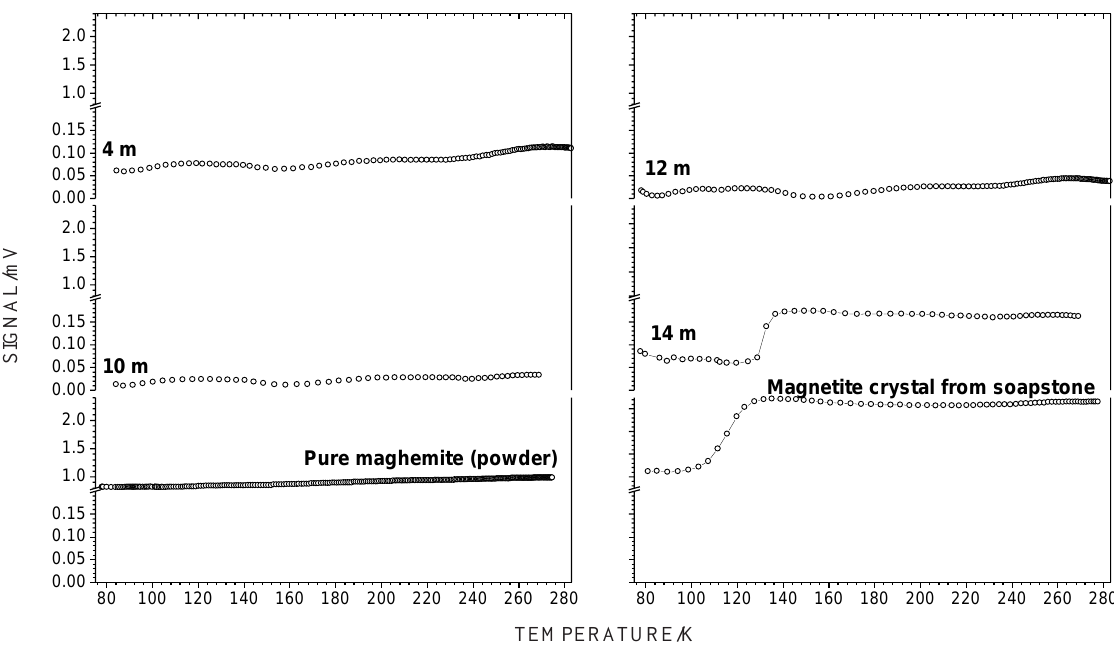
Figure 5. Magnetic susceptibility curves, expressed as electrical signal amplitude, of a selected single crystal of each sample. Pure synthetic maghemite (powder) and a crystal of magnetite from soapstone are also presented, for